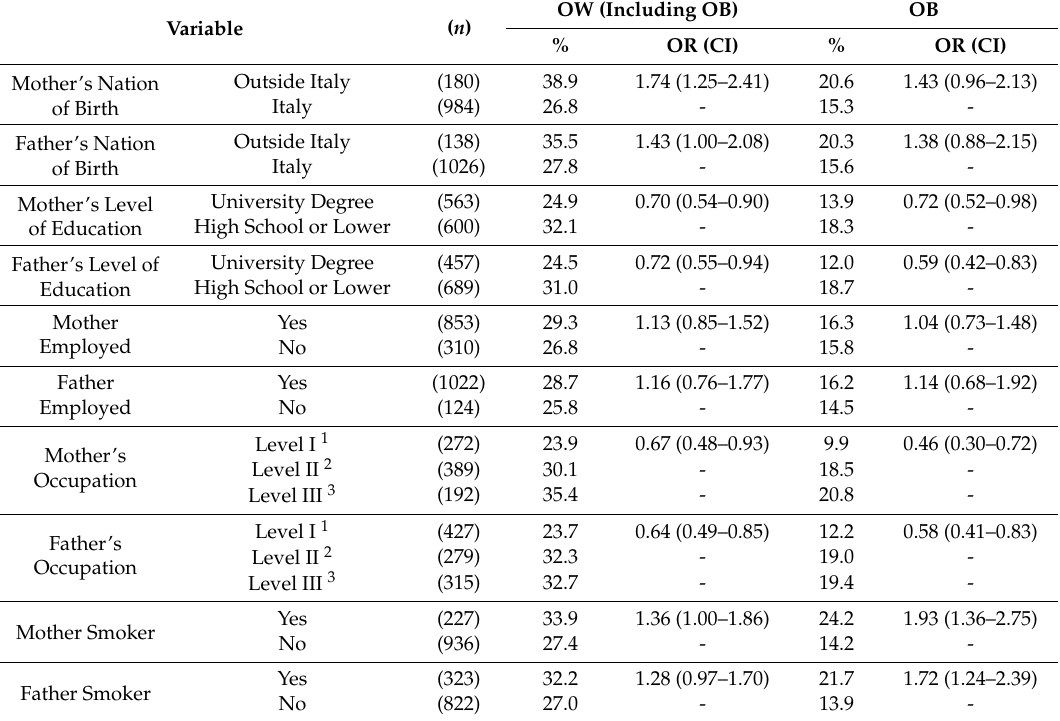
Table 2. Characteristics of the parents of the children in the MAPEC_LIFE